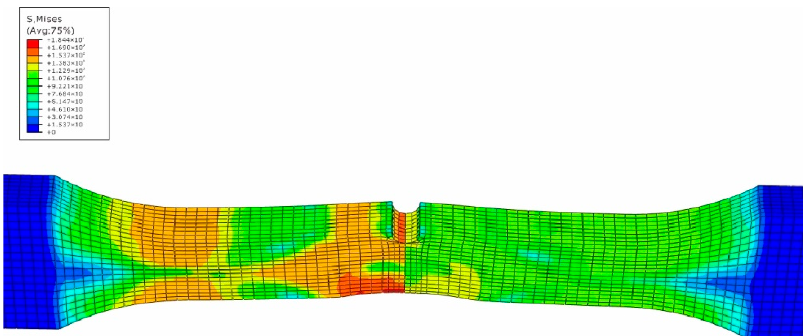
Figure 8. Stress field of back surface with precrack of dissimilar lightweight materials welded joint.